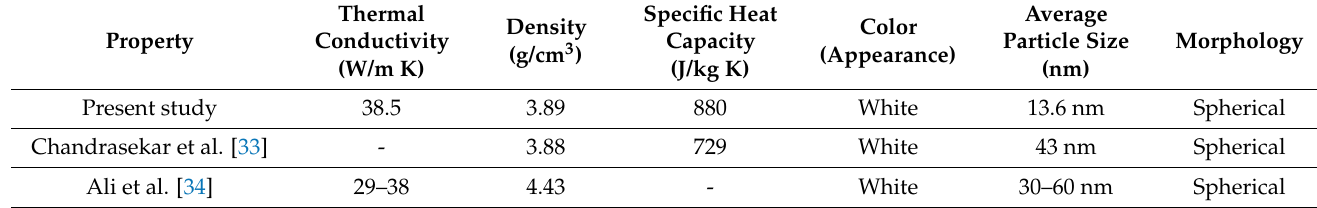
Table 2. Specifications of Al 2 O 3 nanoparticles.